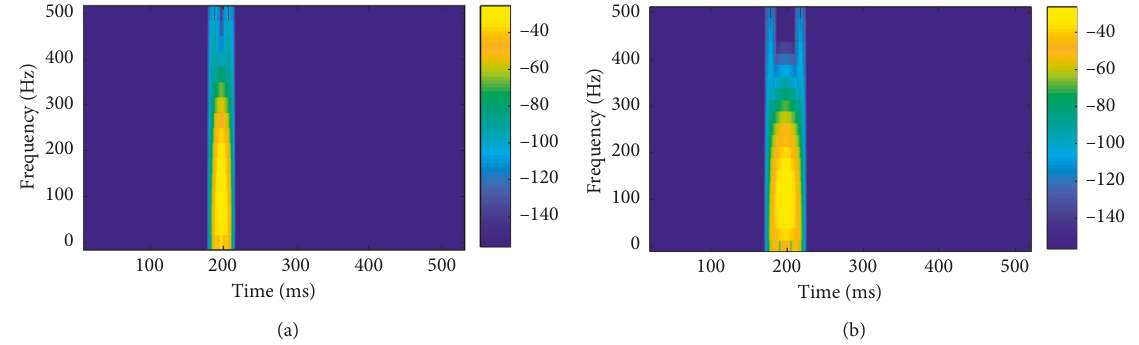
Figure 4: Time-frequency with short-time Fourier transform. (a) Hamming window 20ms. (b) Hamming window 40ms.